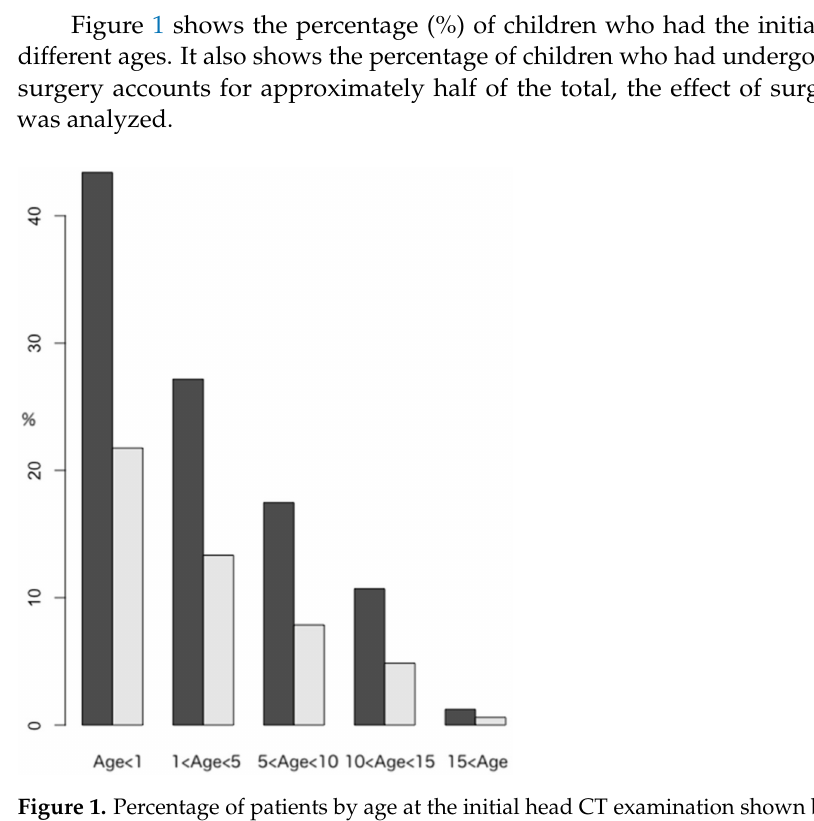
Figure 1. Percentage of patients by age at the initial head CT examination shown by black bars. Gray bars show the percentage of these patients who underwent